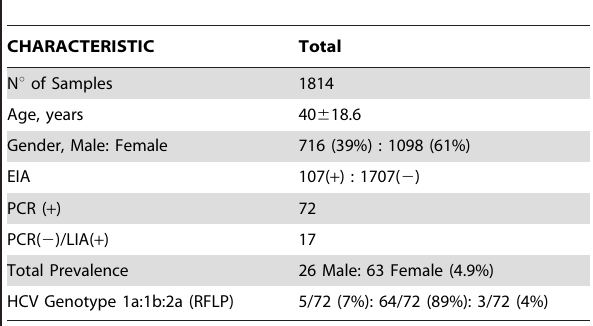
Table 1. Epidemiological data.